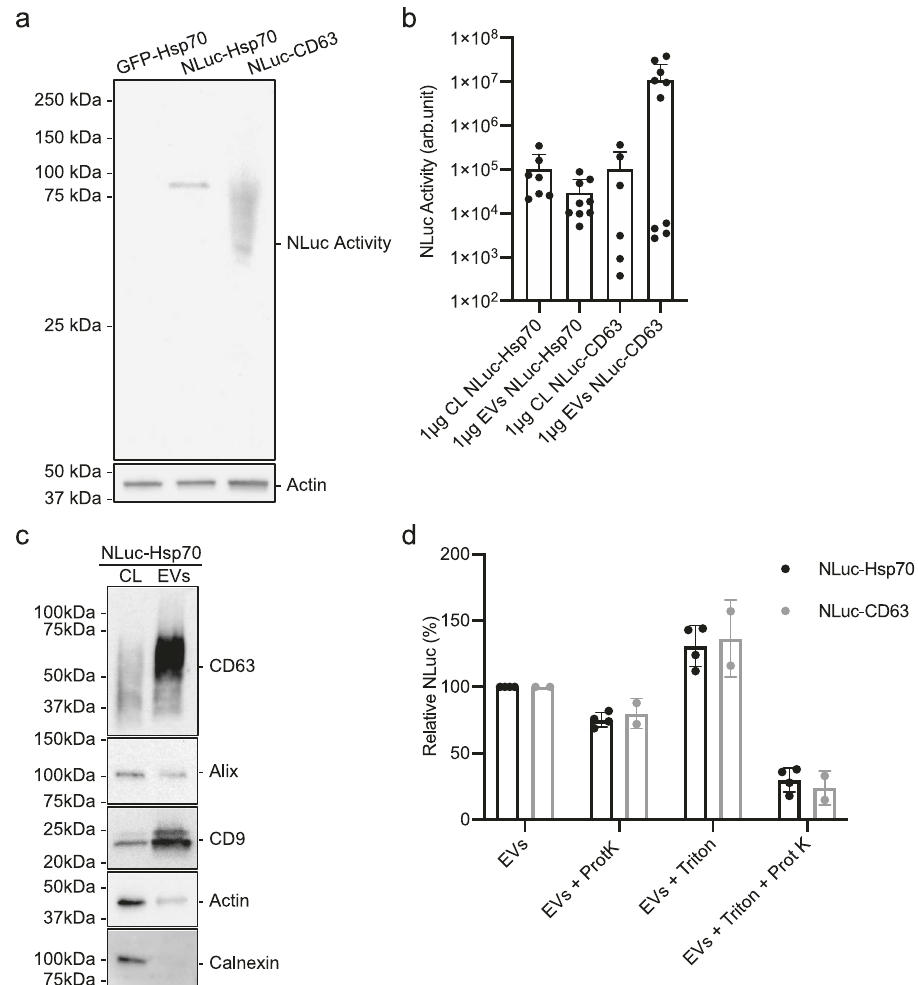
Fig. 1 NLuc-Hsp70 and NLuc-CD63 EV characterization. a In-gel detection of NLuc-Hsp70 and NLuc-CD63 activity. Equal protein amount of cell lysates from HeLa GFP-Hsp70 (negative control), stable HeLa NLuc-Hsp70, and transient HeLa NLuc-CD63 (upper gel) were loaded. As a control, actin was tested by immunoblot on the same samples (lower gel). This blot is representative of 2 independent experiments. b NLuc activity measurement in 1 μ g of cell lysate (CL) or EVs from stable HeLa NLuc-Hsp70 or transient HeLa NLuc-CD63. Each dot is an independent replicate and represents the mean of 2 or 3 technical replicates. From left to right, n = 7, 9, 6, 10. Error bars represent standard deviations. c Immunoblots of cell lysate (CL) and EVs from stable HeLa NLuc-Hsp70. Equal amounts of protein were loaded to analyze CD9, CD63, Actin, Alix, and calnexin. This blot is representative of three independent experiments. d Protease protection assay on NLuc-Hsp70 (black) or NLuc-CD63 (gray) EVs, treated or not with proteinase K and/or detergent. Non- treated EVs were set to 100%. Each dot is an independent replicate and represents the mean of 3 technical replicates, n = 4 for NLuc-Hsp70, n = 2 for NLuc-CD63. Error bars represent standard